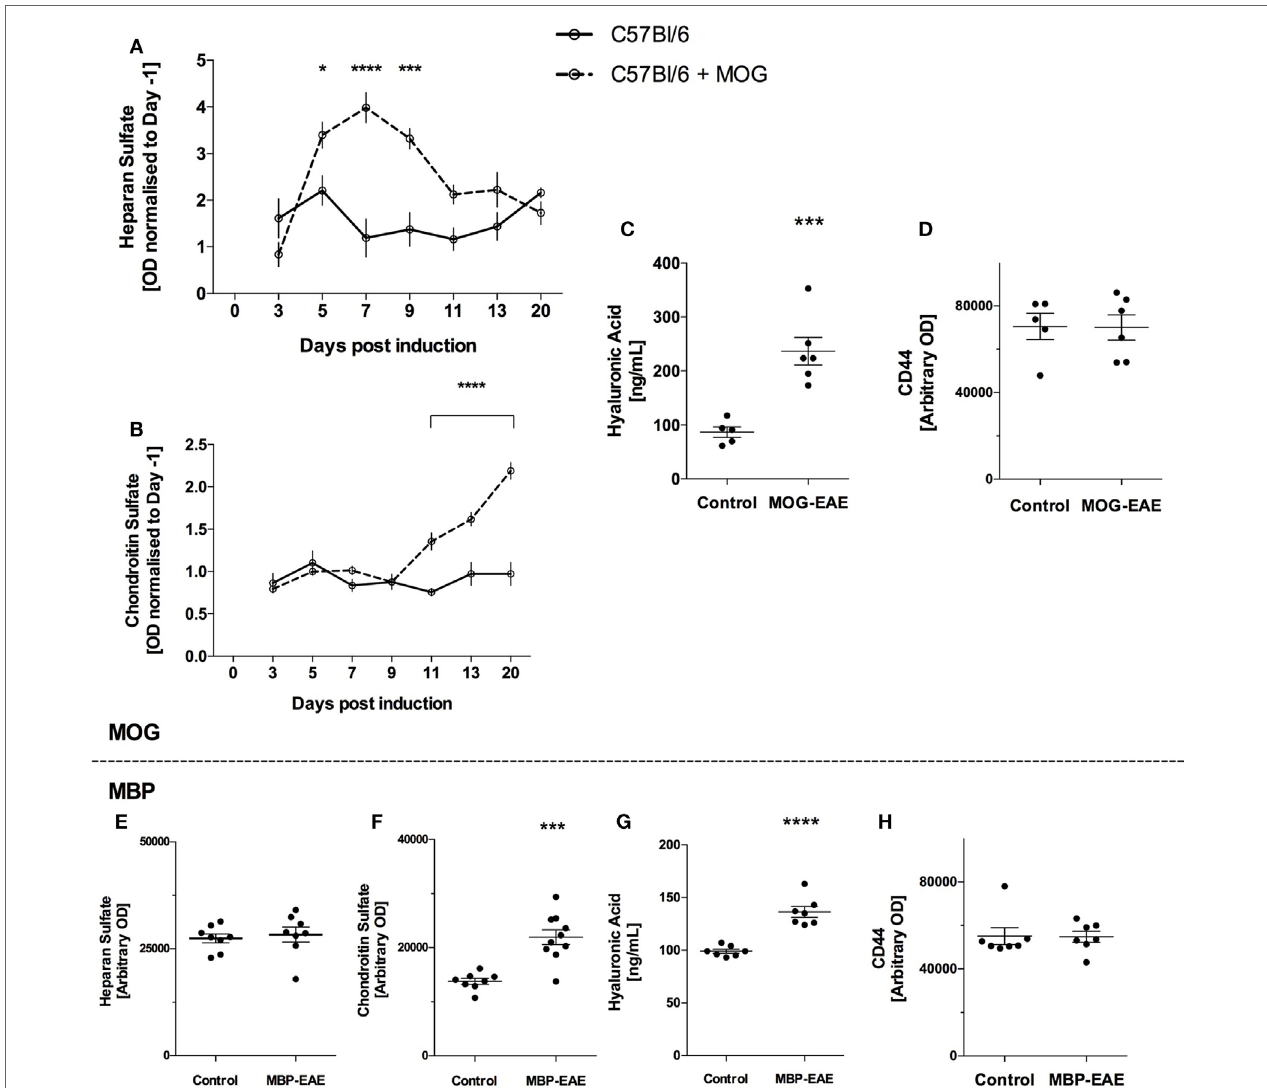
FigUre 2 | Sugar-based glycocalyx (GLX) markers significantly increased in plasma with disease course in myelin oligodendrocyte glycoprotein (MOG)-experimental autoimmune encephalitis (EAE) and are increased in late-stage myelin basic protein (MBP)-EAE. Sugar-based glycosaminoglycans heparan sulfate (HS), chondroitin sulfate (CS), and hyaluronic acid (HA) follow disease course in MOG- and MBP-EAE. (a) HS increases in the plasma at an early time point and returns to baseline are present manifest ( Figure 1a ). (B) Conversely, CS increases significantly in the plasma approximately ~2 days before clinical symptoms present in MOG-EAE. Detection of CS in the plasma proceeds to increase ~2-fold above controls at peak disease severity (day 20). (c) HA is ~2.5-fold higher in peak severity MOG-EAE when compared to controls. (D) CD44, an endothelial hyaluronate receptor did not vary between groups. Similar to MOG-EAE at peak disease severity, plasma from MBP-EAE at peak disease severity shows unchanged HS levels between diseased and control rats (e) , and significantly higher CS and HA levels when compared to controls (F,g) . CD44 (h) did not vary between groups. Data are presented as line graphs (a,B) normalized to pre-EAE levels (day 1) and (c–h) dot plots of control vs. EAE. Statistical significance is reported when p -value is < 0.05 where *, ***, and **** refer to p < 0.05, 0.001, and 0.0001, respectively, after testing for normality (Shaprio–Wilk) and equal variance and running the following statistical analysis: (a,B) two-way ANOVA, (c–e) Student’s t